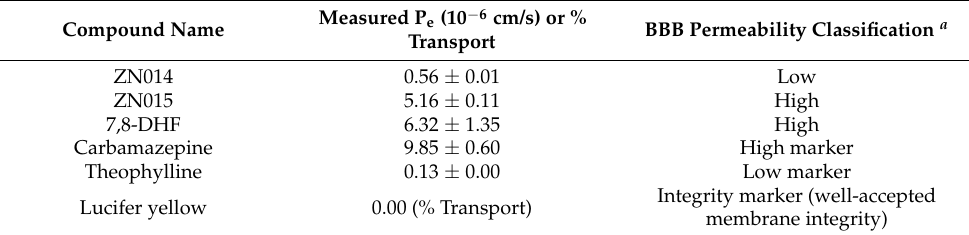
Table 2. Permeability of ZN014, ZN015, 7,8-DHF and the QC compound by the PAMPA-BBB